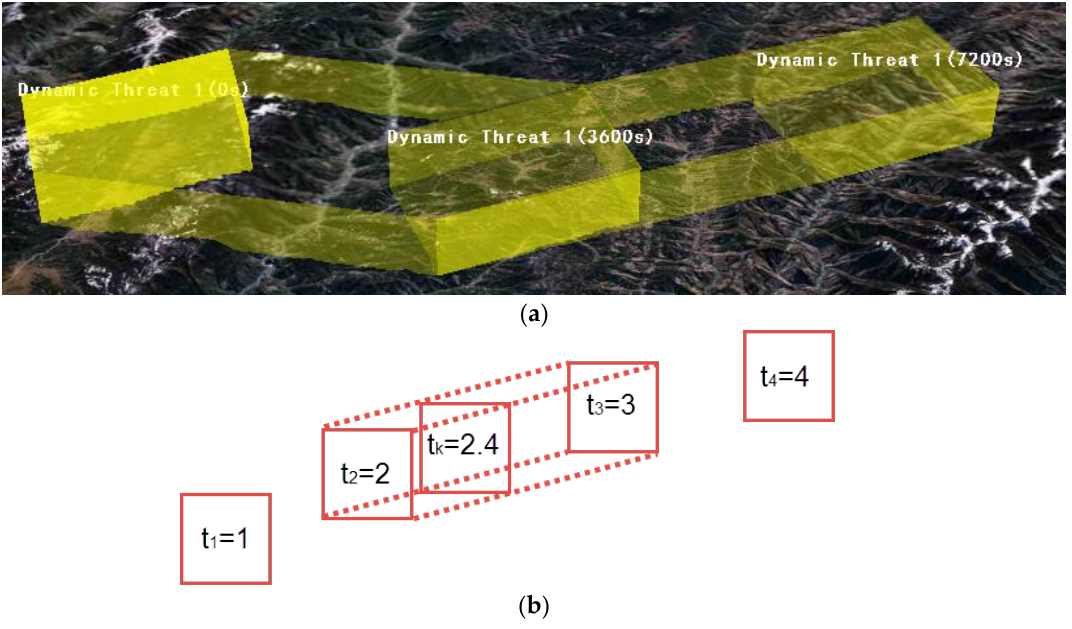
Figure 7. Dynamic threat model. ( a ) There is a dynamic threat described as {{(99.94497, 27.60066), (99.859,